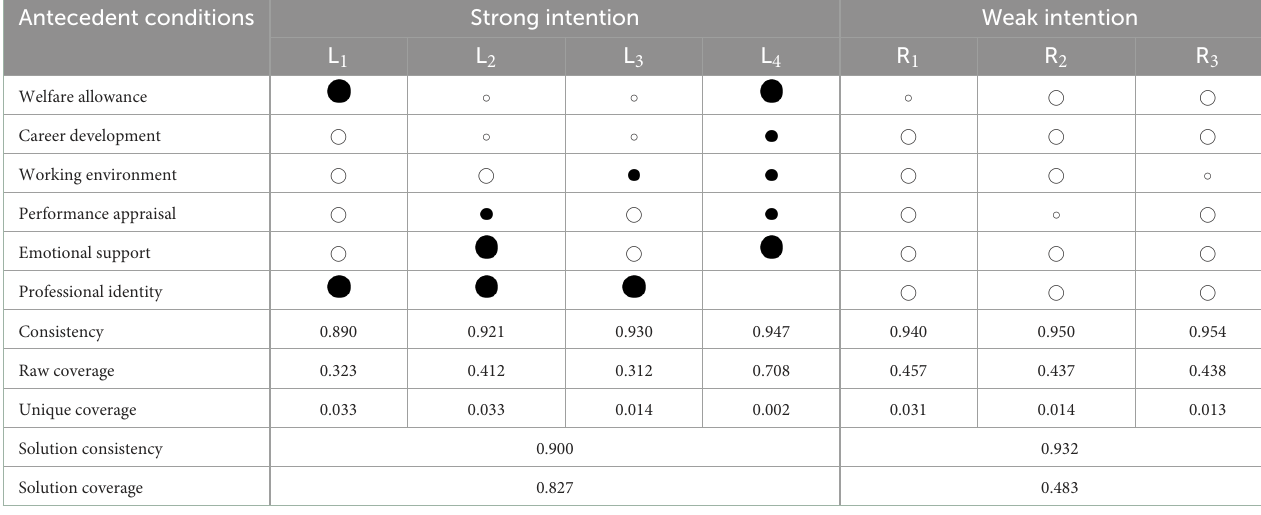
TABLE 6 Configurations of rural teachers’ retention intention influential